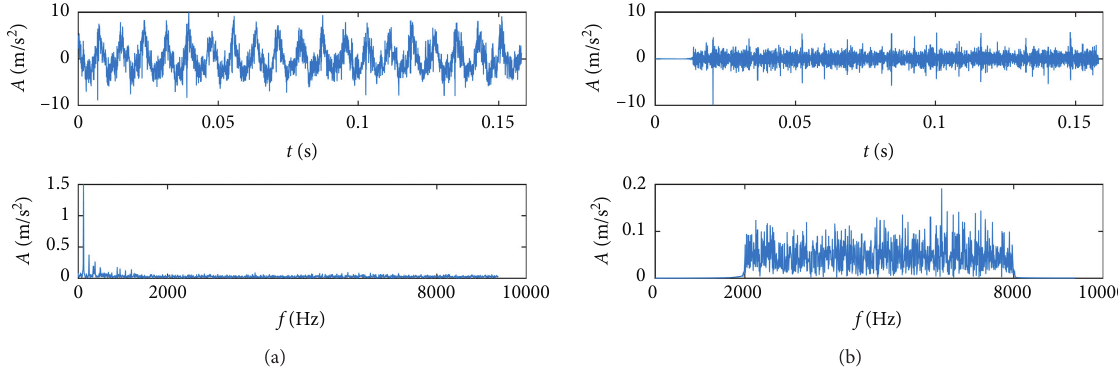
Figure 6: Vibration signal of the time domain and frequency domain under the normal state with 5 dB white noise. (a) Original signal. (b) Filtered signal.